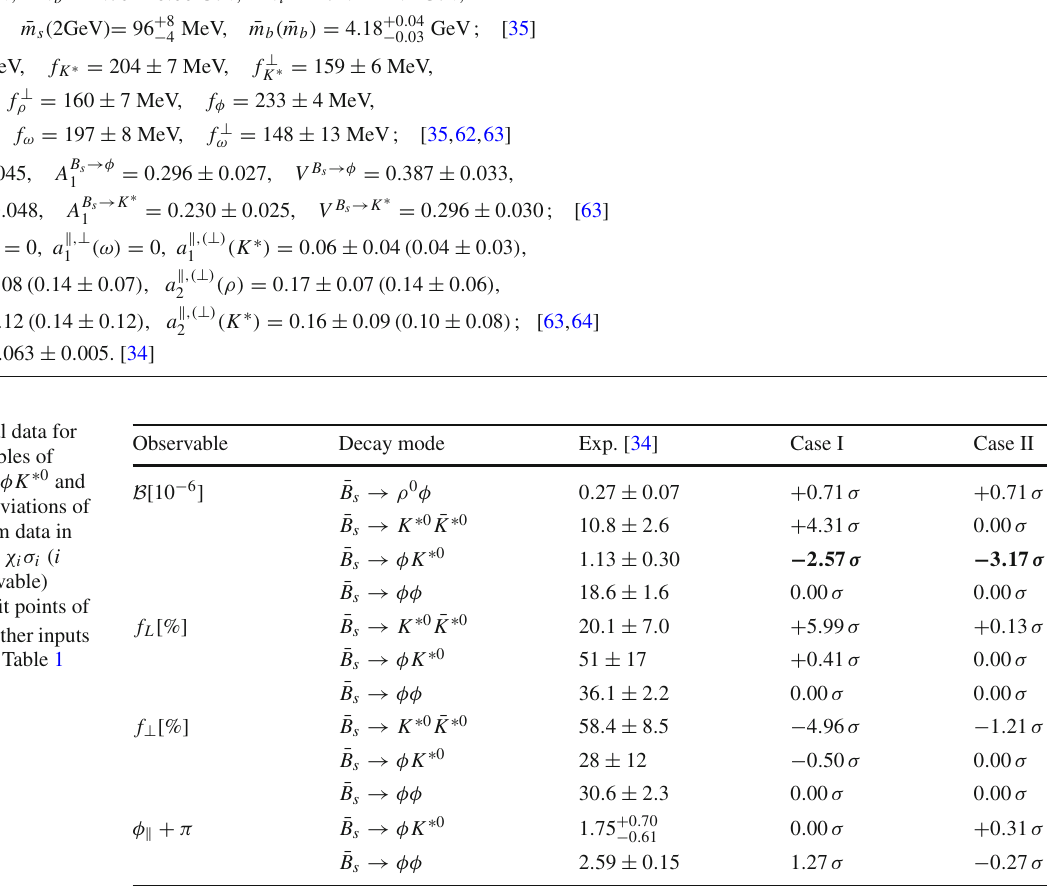
Table 1 Values of the input parameters: Wolfenstein parameters, pole and running quark masses, decay constants, form factors, Gegenbauer moments and decay width parameter y s A = 0 . 8250 + 0 . 0071 − , λ = 0 . 22509 + 0 . 00029 − 0 . 0111 0 . 00028